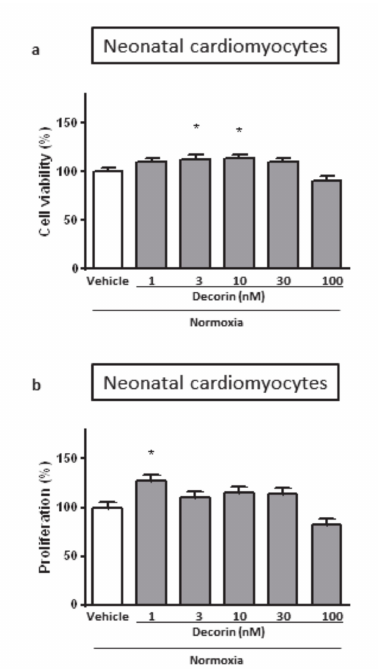
Figure 1. The e ff ect of di ff erent concentrations of decorin on the ( a ) cell viability and ( b ) cell proliferation in Neonatal Rat Cardiac Myocytes (NRCMs) in normoxic conditions. Cell viability measured by calcein staining based on intracellular esterase’s enzyme activity. The rate of proliferation was evaluated by BrdU incorporation into the cells. Data are normalized to vehicle-treated Normoxia and presented as mean ± S.E.M. One-Way ANOVA, Dunnett’s multiple comparison test, * p < 0.05 vs. vehicle treated cells ( n =